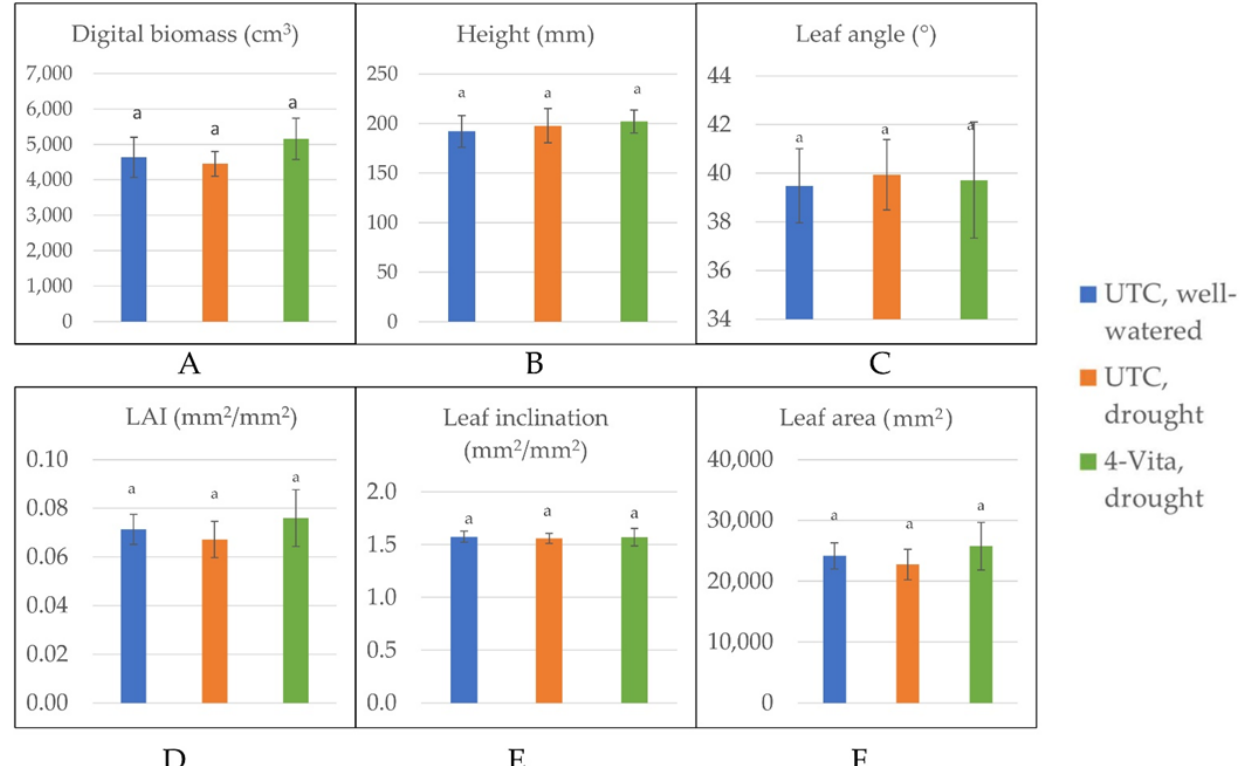
Figure 4. Morphological parameters observed 4 DAT by the LLPhP (scanning platform). ( A ) Digital biomass, ( B ) height, ( C ) leaf angle, ( D ) LAI (leaf area index), ( E ) leaf inclination, ( F ) leaf area. For each trait, at least one letter in common indicates no significant difference.